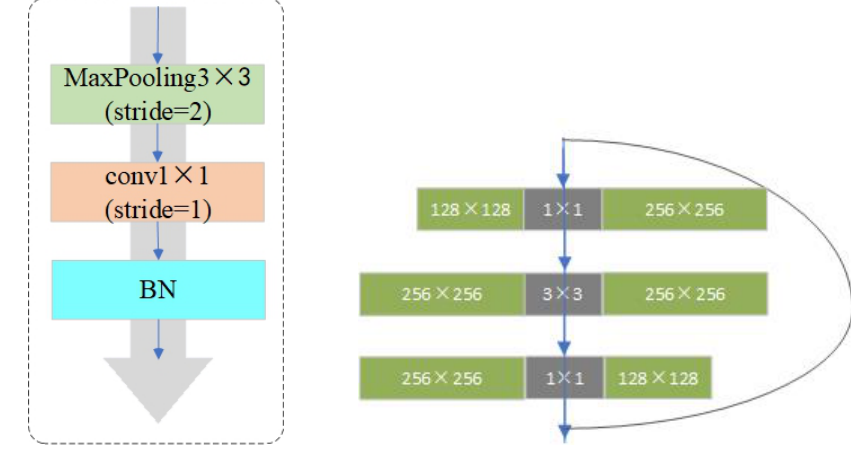
Figure 4. The improved structure of our